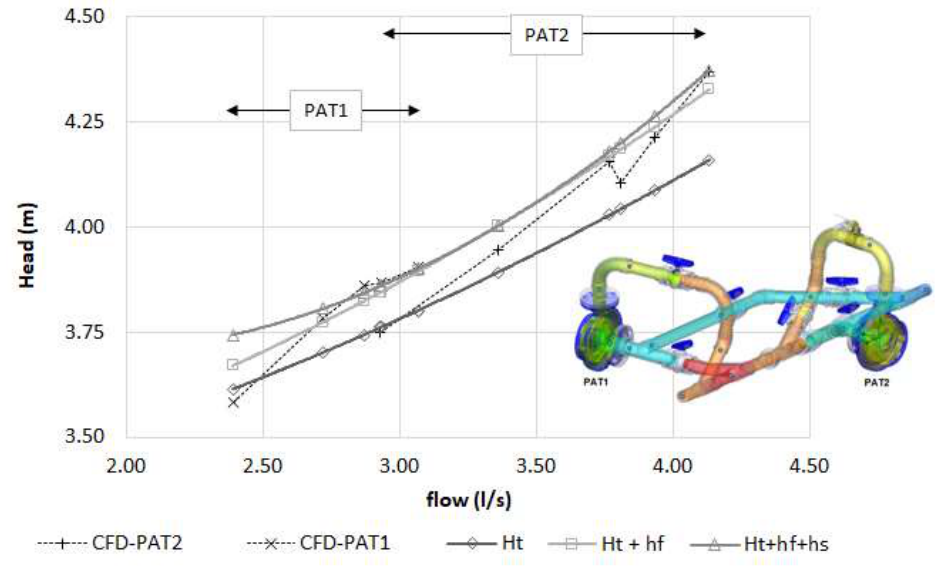
Figure 16. Hydraulic losses distribution in each PAT.